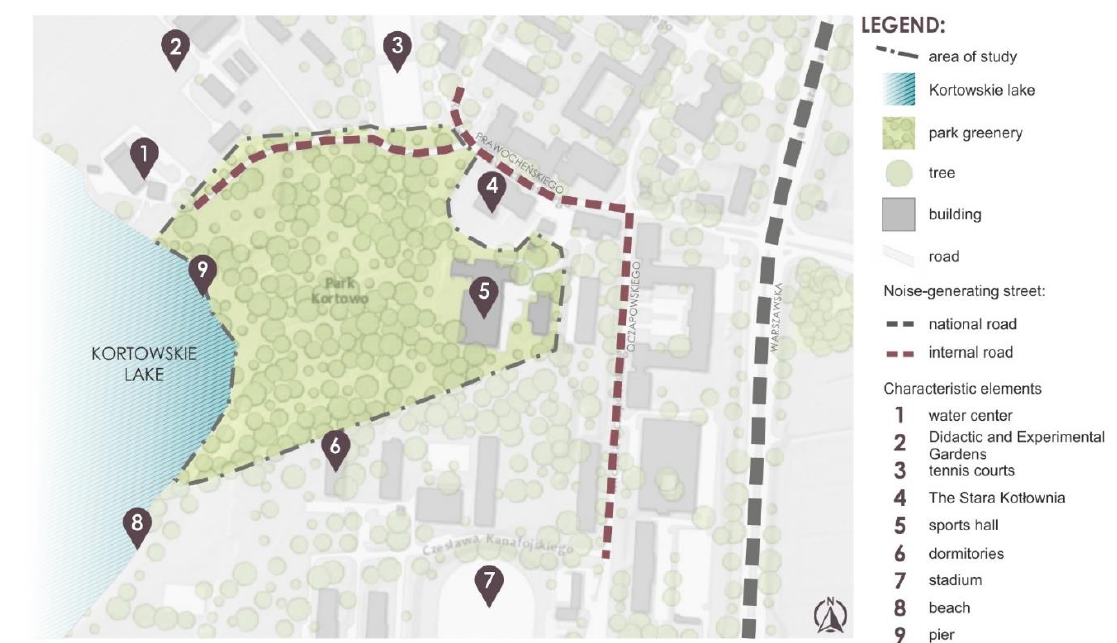
Figure 2. Map with the location of Kortowo park and its surroundings in Kortowo Campus. The basic characteristic of the analyzed park is given in Table 1. Table 1. The basic characteristics of the examined park.